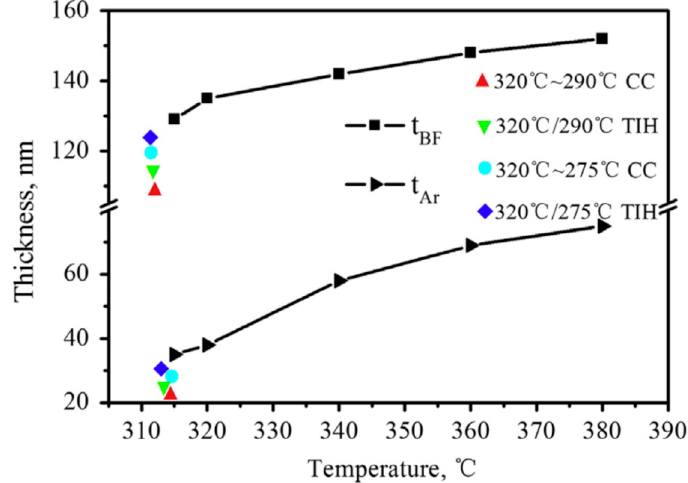
Figure 2. Relationship between t BF , t Ar and transformation temperature in 34MnSi-CrAlNiMo steel. TIH stands for Two Isothermal holding and CC for continuous cooling. Extracted from reference [23]. Reproduced with permission from Elsevier, 2017.